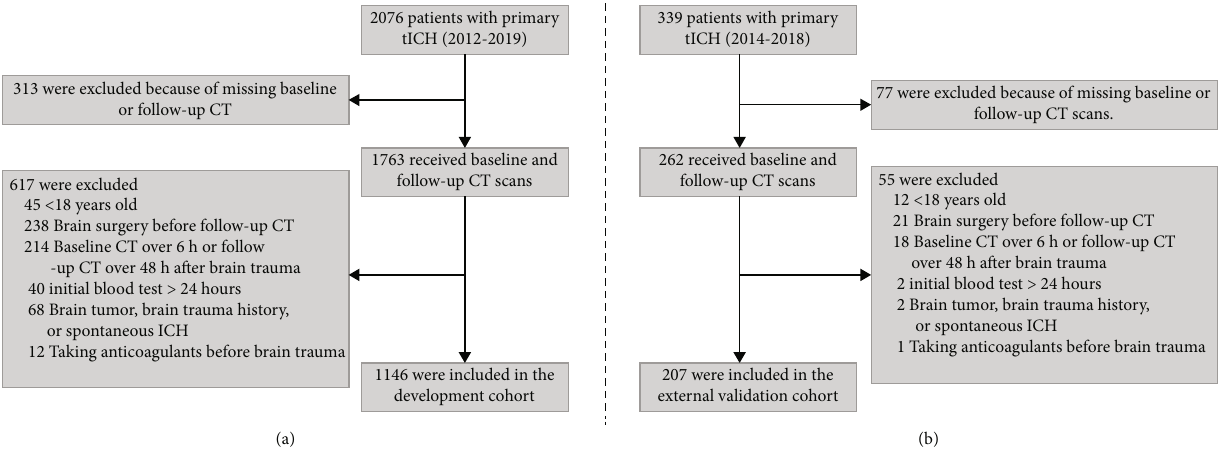
Figure 1: Flowchart of patient selection process including inclusion and exclusion criteria. Patients in the fi nal cohort were retrospectively selected from the First A ffi liated Hospital of Shantou University Medical College, the Second A ffi liated Hospital of Shantou University Medical College, and the A ffi liated Jieyang Hospital of Sun Yat-sen University between January 1, 2012, and April 30, 2019 (a). Patients in the validation cohort were prospectively selected from Fuzhou General Hospital of Xiamen University between March 2014 and June 2018 (b). CT=noncontrast computed